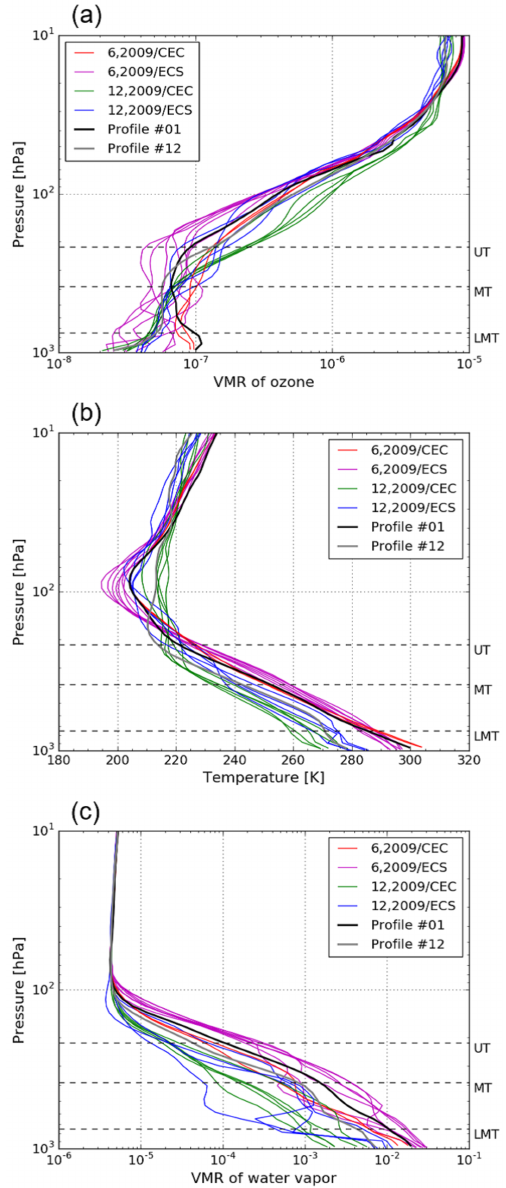
Figure 2. Twenty atmospheric scenarios used in this study: (a) VMR of ozone, (b) temperature, and (c) VMR of water va- por. They are divided into four groups, as denoted by color: CEC in June 2009 (red), ECS in June 2009 (purple), CEC in Decem- ber 2009 (green), and ECS in December 2009 (blue). Two example profiles (nos. 01 and 12, black and gray lines, respectively) were used to obtain results shown in Figs. 5 and